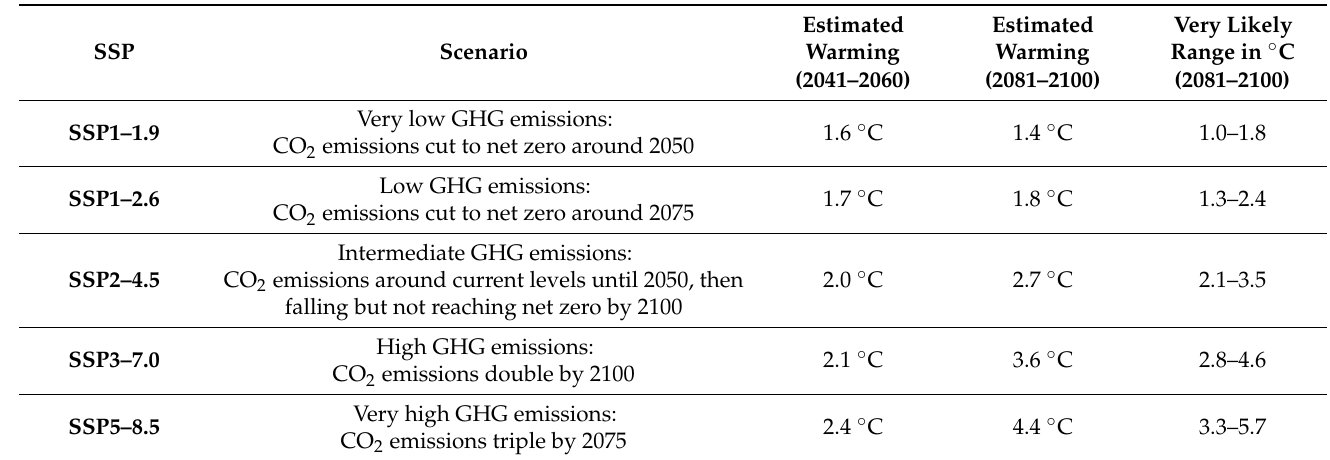
Table 2. SSPs in the IPCC AR6 [44].